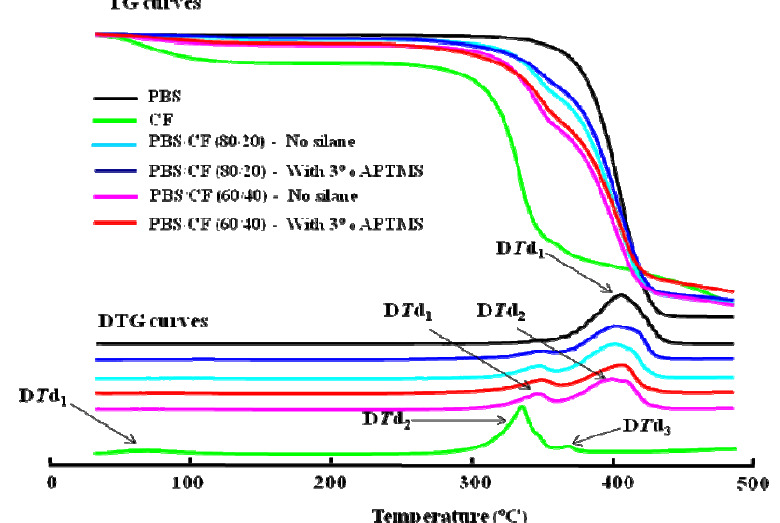
Figure 4. Thermogravimetry (TG) and derivative thermograms (DTG) curves of PBS, CF, PBS/CF (80/20 wt%), and PBS/CF (60/40 wt%) composites with and without 3%-APTMS